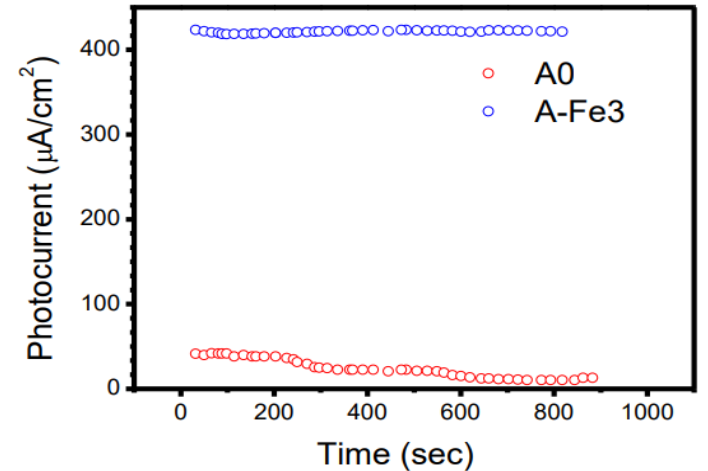
Figure 6. Chronoamperograms over 900 s (at 0.80 V (vs. Ag/AgCl) in the solution of HCl adjusted to pH 2, with light illumination (100 W of halogen lamp) of flexible FTO slides coated with control thin films comprising of PANi A0 and A-Fe3.